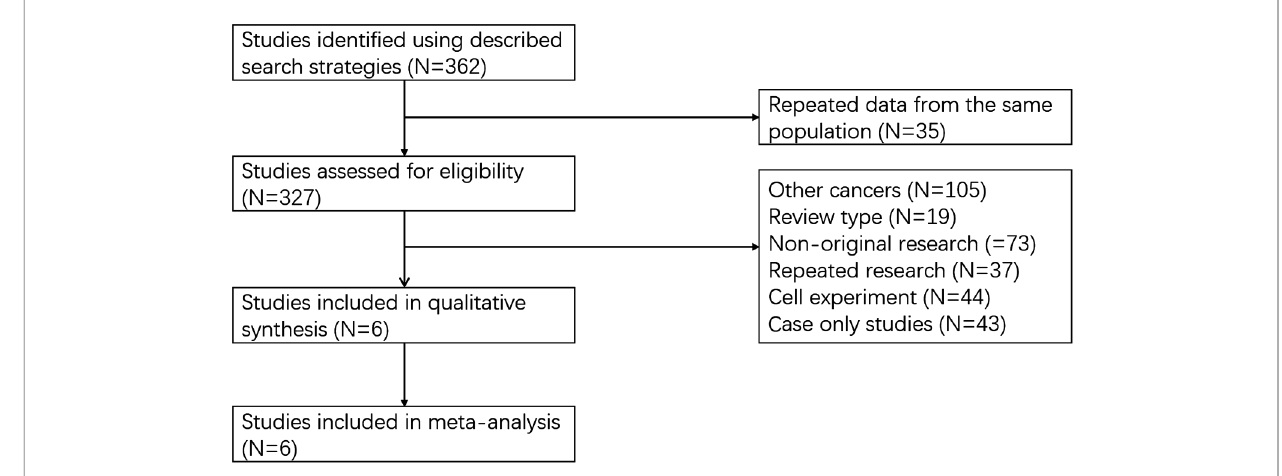
FIGURE 1 | Flow chart of research data